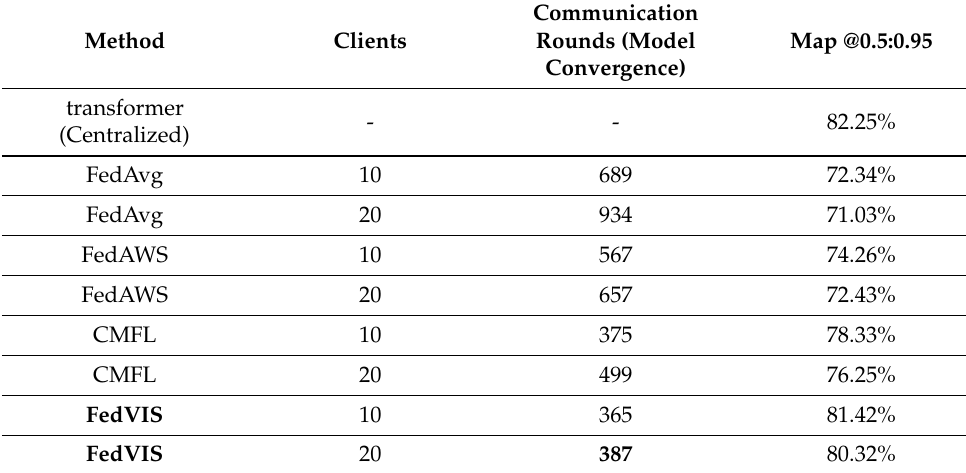
Table 2. Comparison of detection performance under IID distribution. As the number of clients increases, the accuracy achieved by the other algorithmic models shows a decrease and the number of communication rounds required increases significantly, while our method can still maintain a better detection performance.